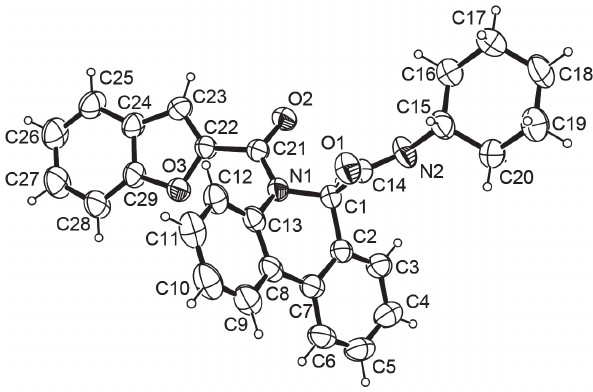
Table 2: Fractional atomic coordinates and isotropic or